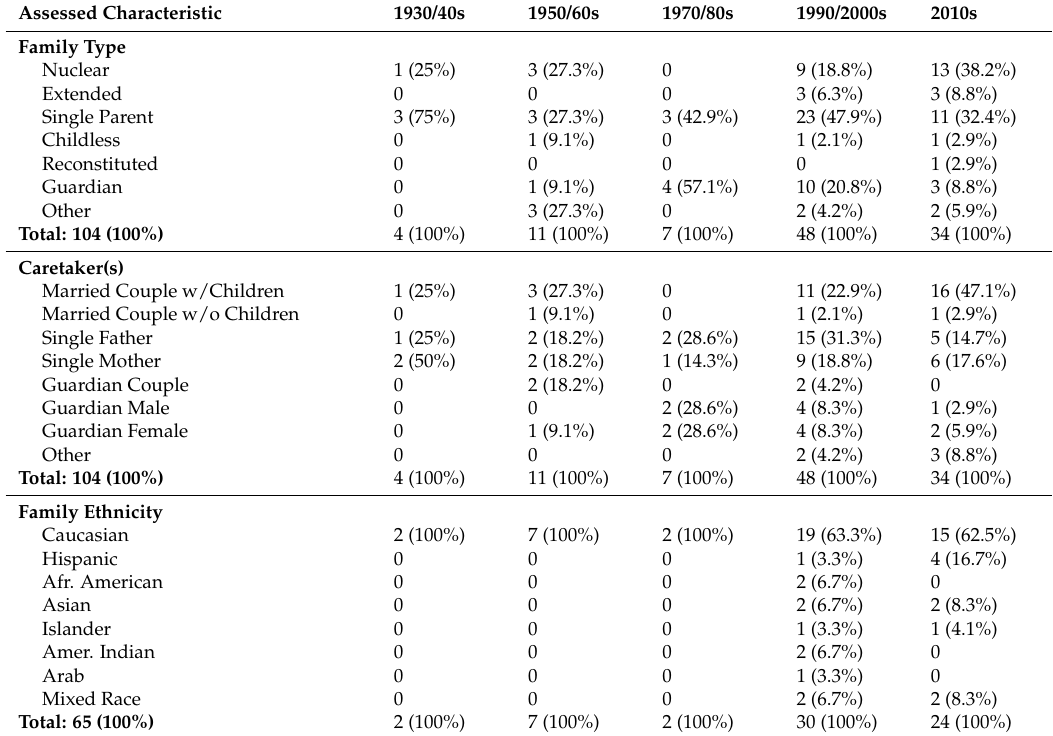
Table 1. Comparative Analysis of Variables by every Two Decades